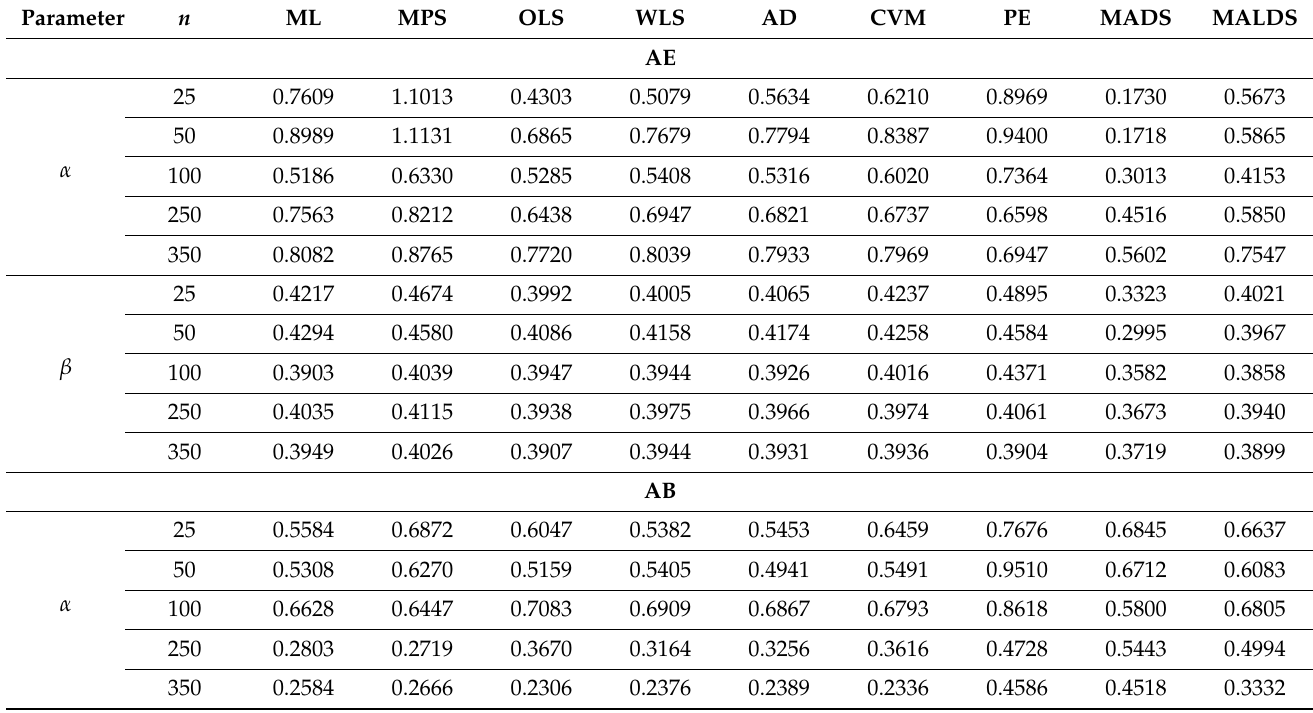
Table 1. AE, AB, and RMSE for α = 0.8 and β =